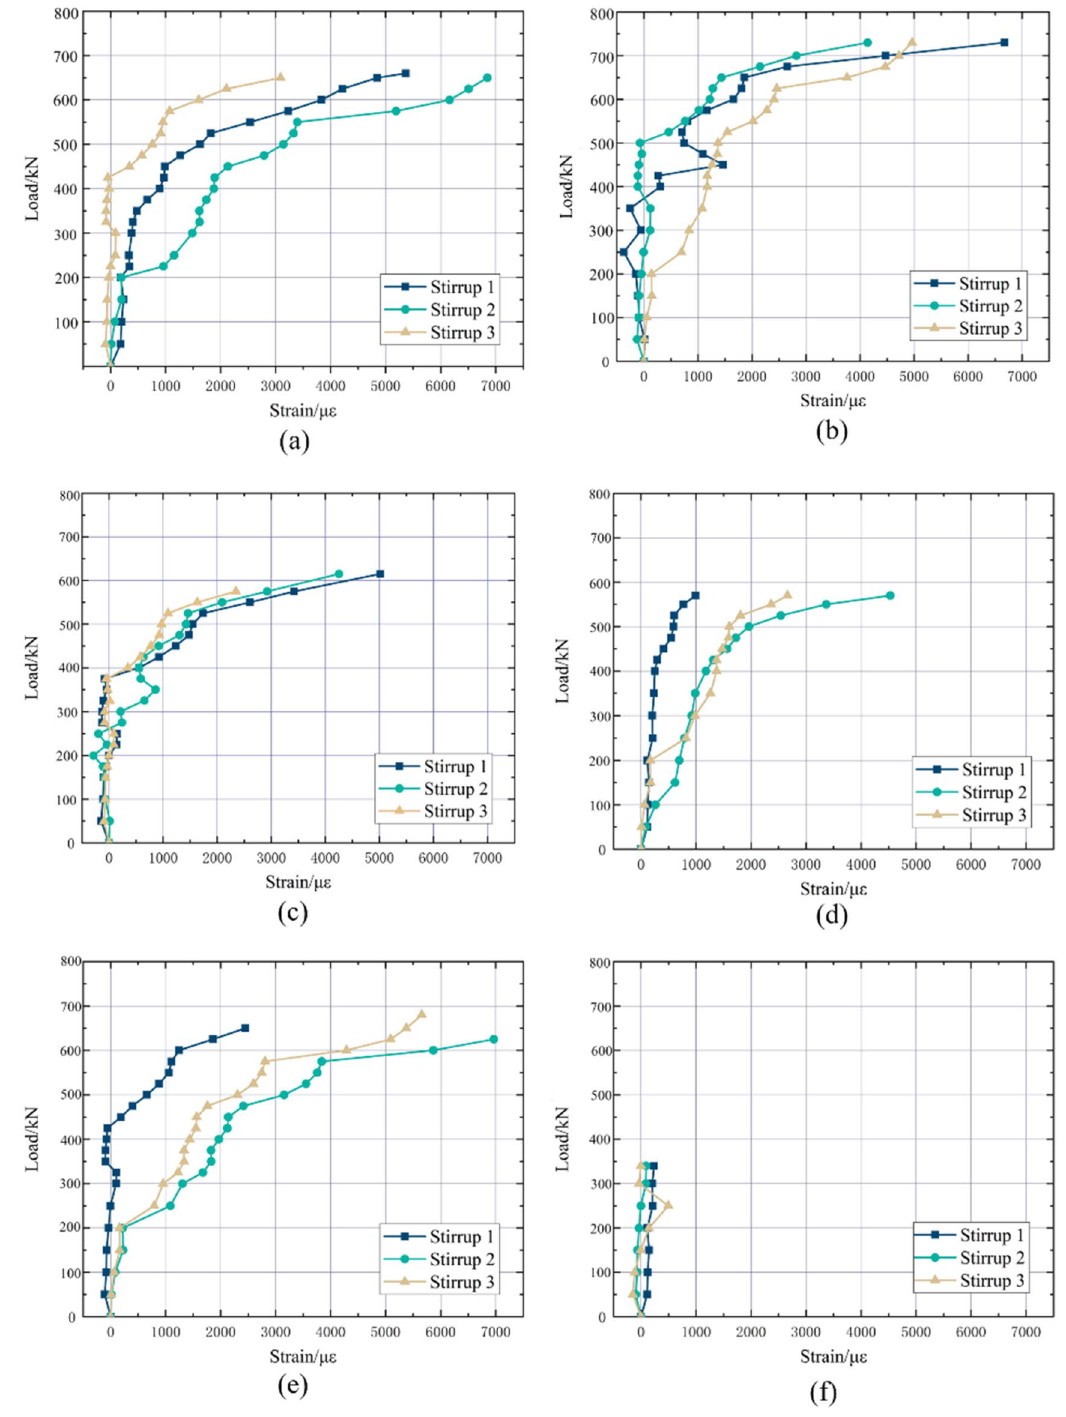
Figure 6. Load-strain curve of stirrups in the test beams’ spear-span area {( a ) UHPC-1; ( b ) UHPC-2; ( c ) UHPC-3; ( d ) UHPC-4; ( e ) UHPC-5; ( f )